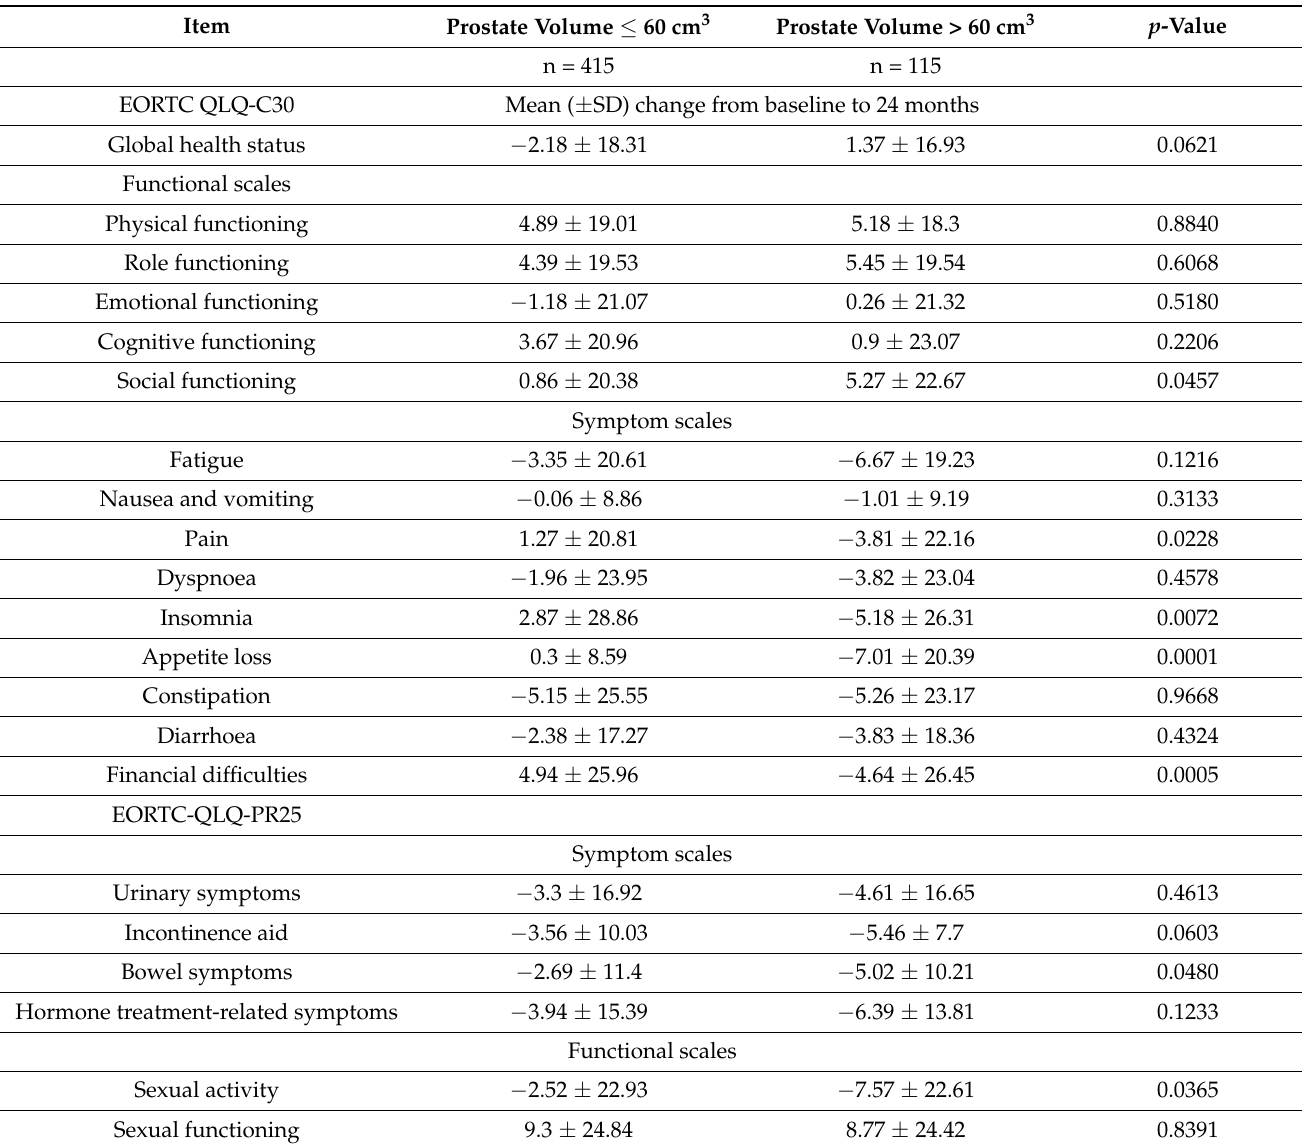
Table 3. Changes in health-related quality of life scores from baseline to month 24 according to prostate